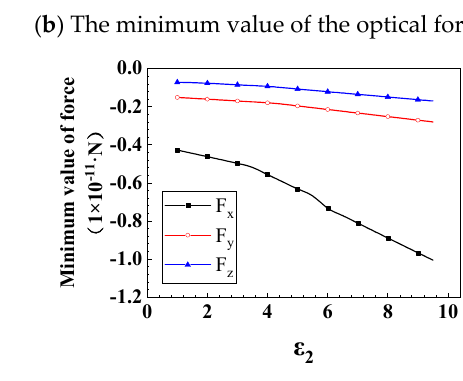
-18 -16 -14 -12 -10 -8 -6 -4 -2